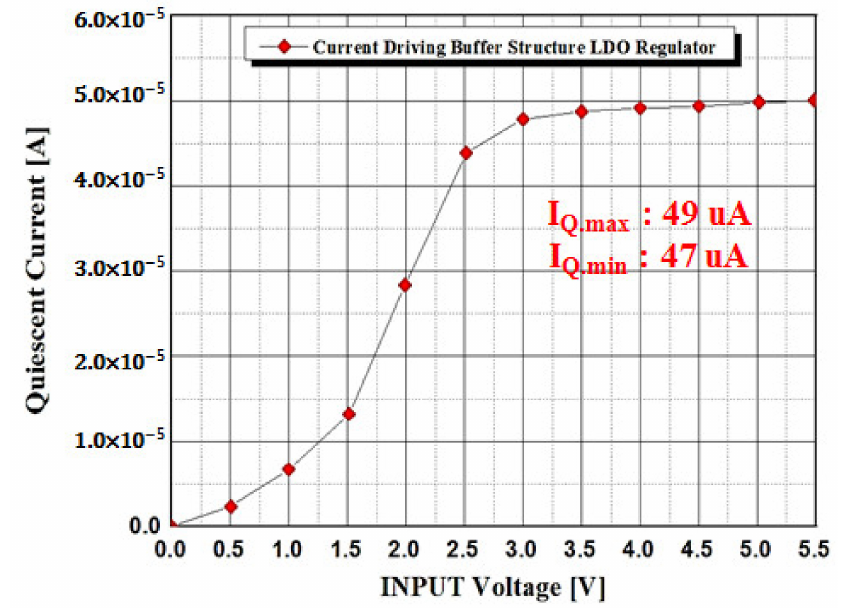
Figure 15. Quiescent current of the proposed LDO